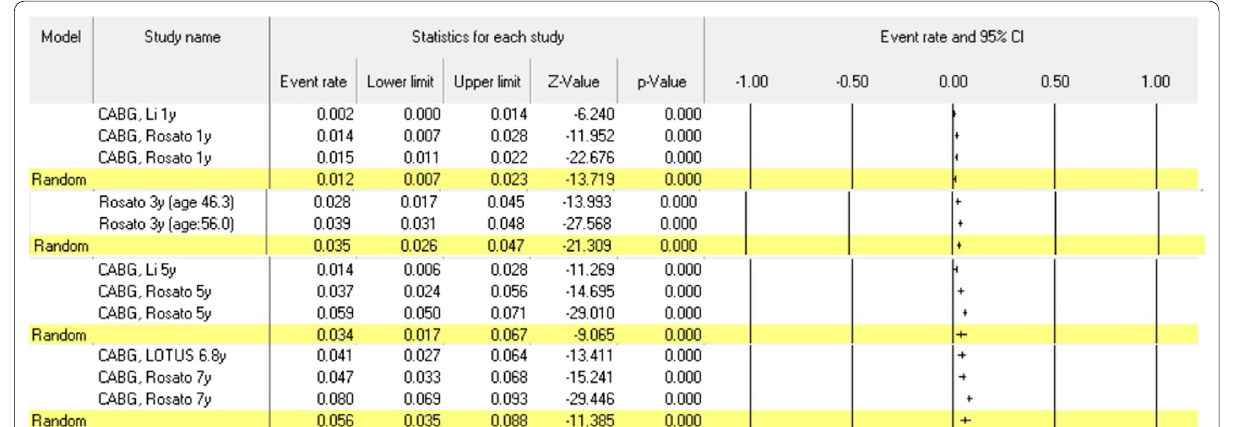
Fig. 2 Death probabilities after CABG in CAD patients under 60 years old at different